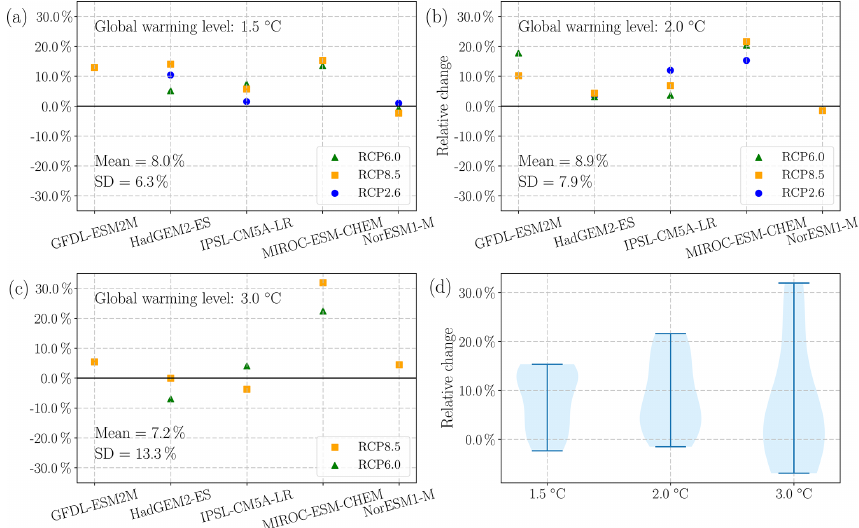
Figure 4. Projected changes in groundwater recharge rate under three warming scenarios compared to the baseline scenario of 1971–2000. Panels (a) , (b) , and (c) are the scatter plots showing the individual simulation results, and panel (d) is the violin plot showing the uncertainty of ensemble